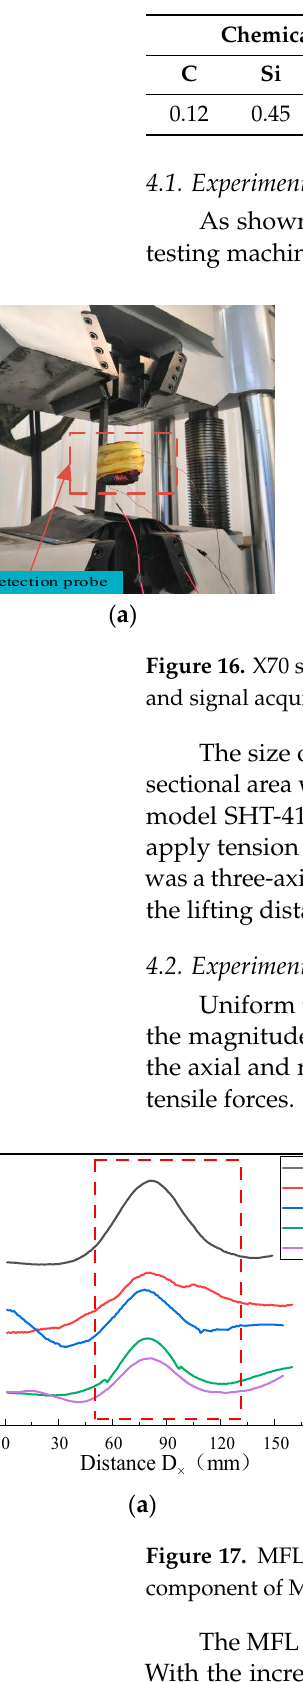
Table 1. Chemical composition and mechanical properties of X70 steel pipe.